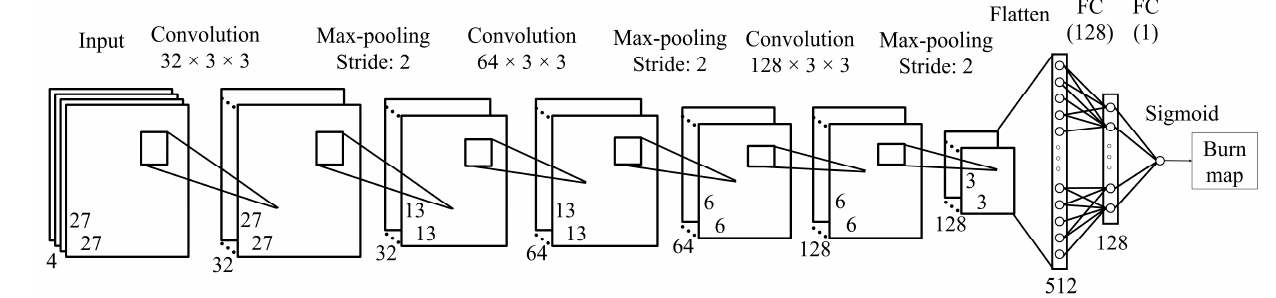
Figure 3. The architecture of the used DCNN model.